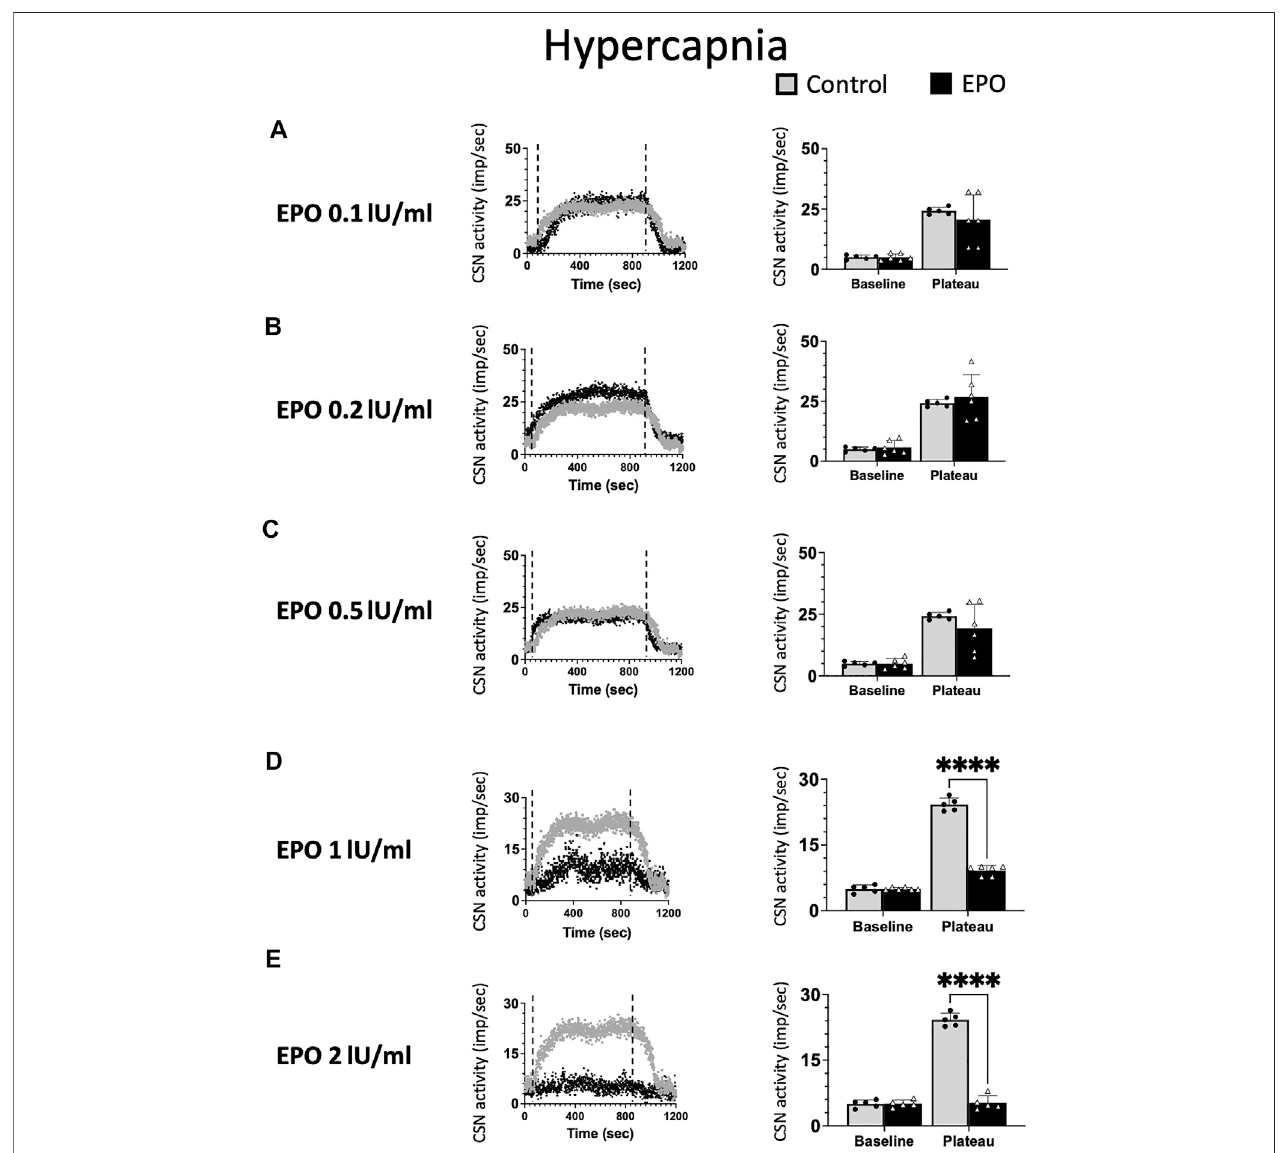
FIGURE 3 | No signi fi cant impact of Erythropoietin (EPO) was evidenced at concentrations of 0.1 (A) , 0.2 (B) and 0.5 (C) IU/ml under hypercapnic conditions (RM Two-way ANOVA F 0.1 (1, 9) (cid:1) 0.744 p (cid:1) 0.411; F 0.2 (1, 9) (cid:1) 0.194 p (cid:1) 0.670; and F 0.5 (1, 9) (cid:1) 0.985 p (cid:1) 0.347). At a concentration of 1 IU/m. EPO leads to a strong inhibitionofCSNactivity(RMTwo-wayANOVAF(1,9) (cid:1) 257 p < 0.0001) (D) and2 IU/mlsupresstheactivityofthecarotidsinusnerve(CSN-RMTwo-wayANOVAF(1, 8) (cid:1) 311 p < 0.0001) (E) . Dashed lines indicate the beginning and end of the hypercapnic stimulus. ****: p <